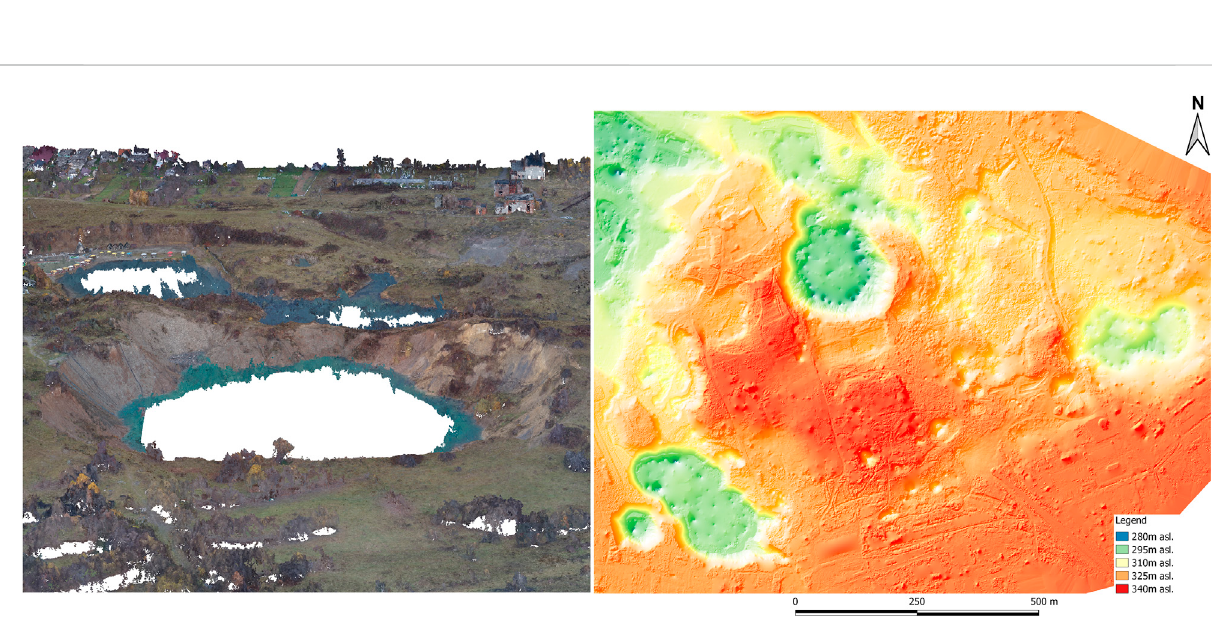
square error of their placement not exceeding 19 mm. As a results of processing aerial survey results in the Pix4Dmapper, a point cloud, digital terrain model (Figure 10) and orthophotomosaic of the research area were created. The resolution of all received data